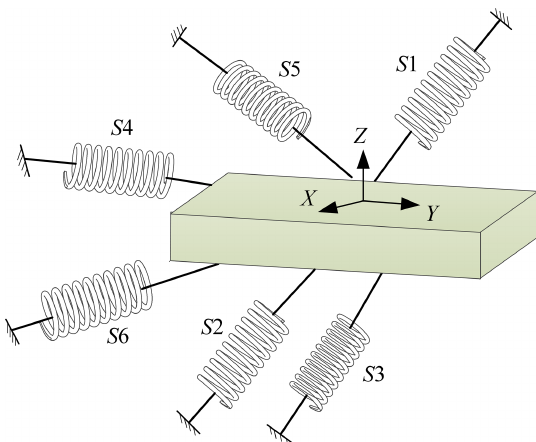
Figure 5. Stiffness matrix spring distribution diagram.